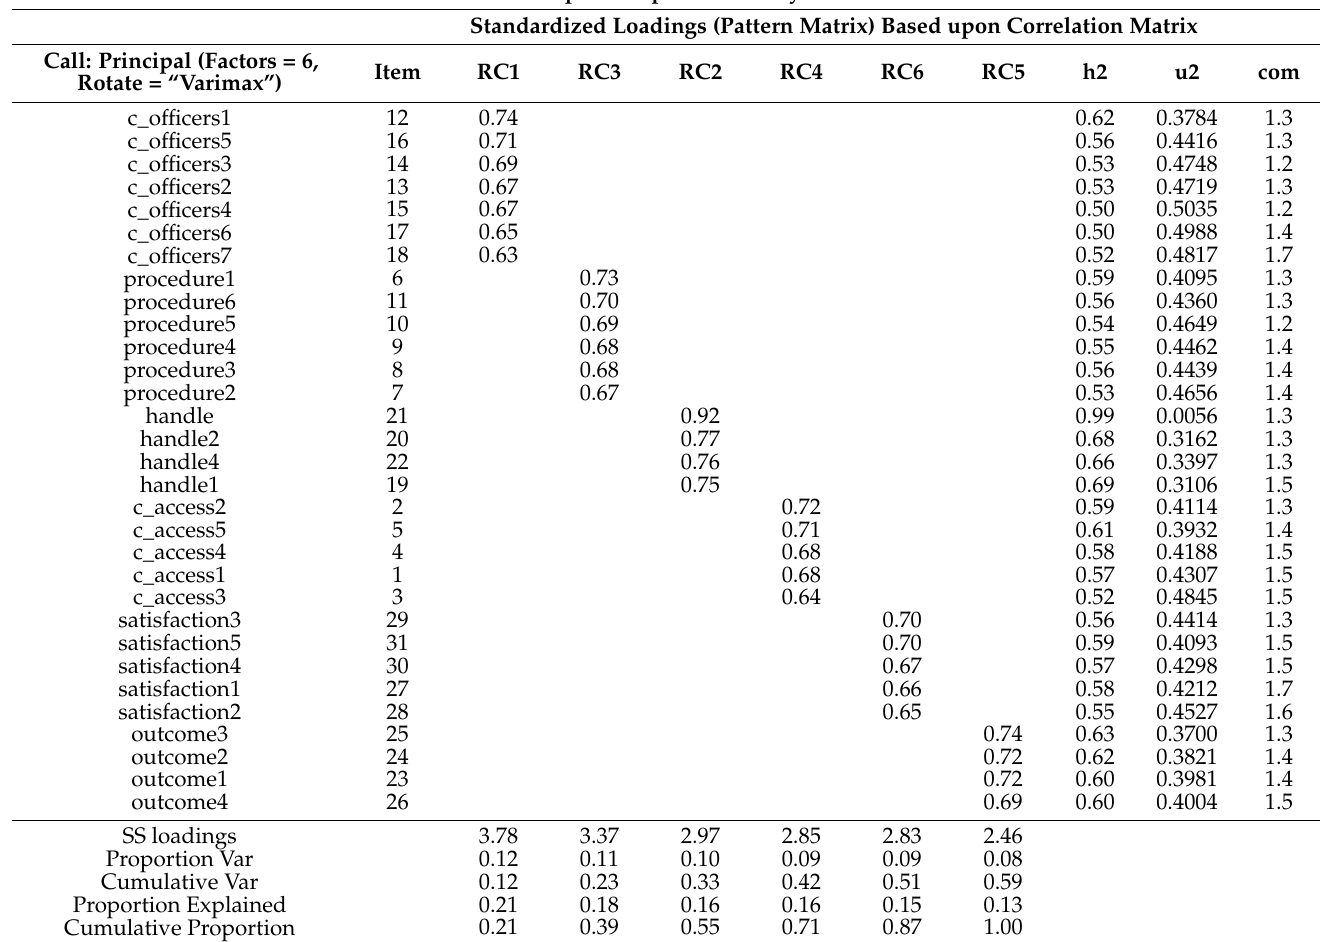
Table 3. Exploratory factor